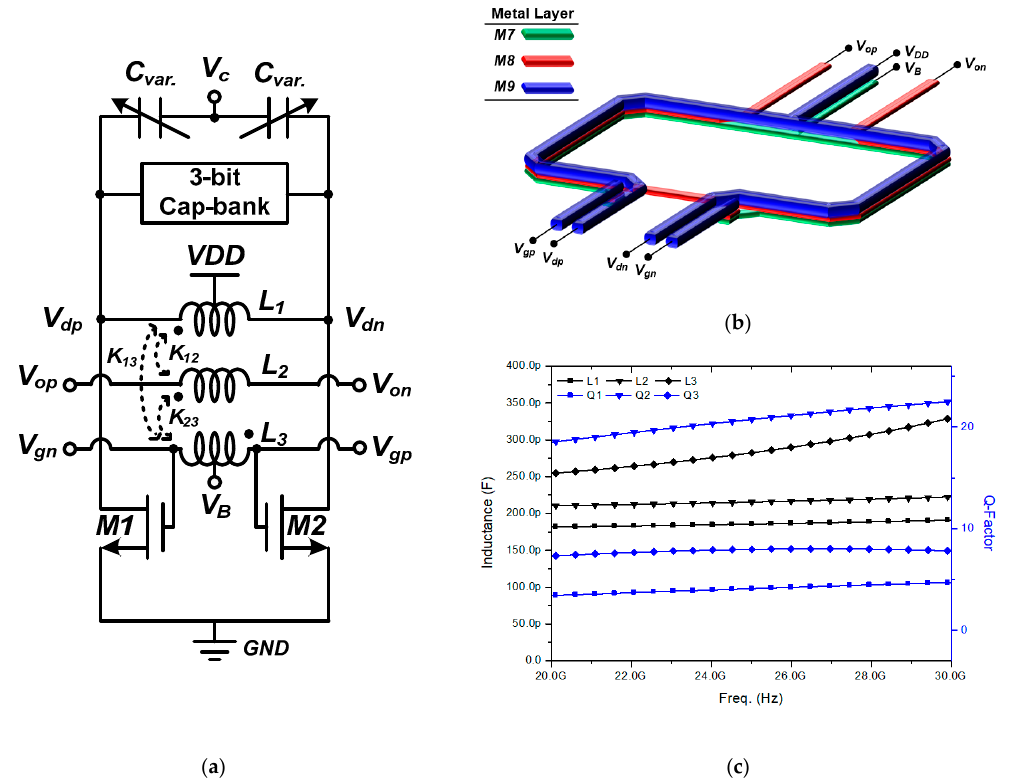
Figure 2. This figure is the circuit diagram of the core part of the proposed class-C VCO and the figure of the transformer. ( a ) is the VCO of NMOS cross-coupled differential structure. It uses a varactor, a 3-bit cap-bank and three inductors. ( b ) is a 3-D drawing of transformers for three inductors and ( c ) is a simulation results plotting L and Q-factor according to the frequency change of transformers.